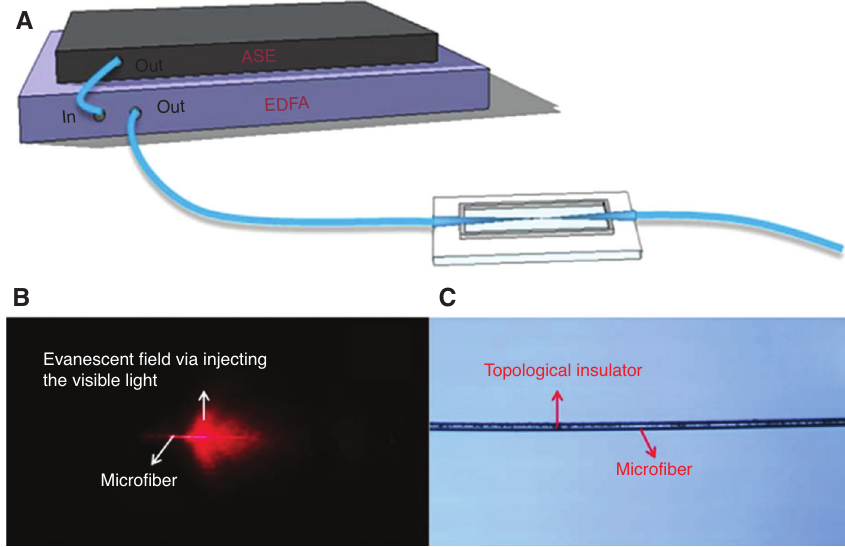
Figure 2: 2D material-decorated microfiber photonic device fabrication using the deposition method. (A) Experimental setup. (B) Evanescent field of a microfiber observed by visible light. (C) Microscopy image of the fabricated microfiber- based TISA. Reproduced with permission [122]. Copyright 2013, The Optical